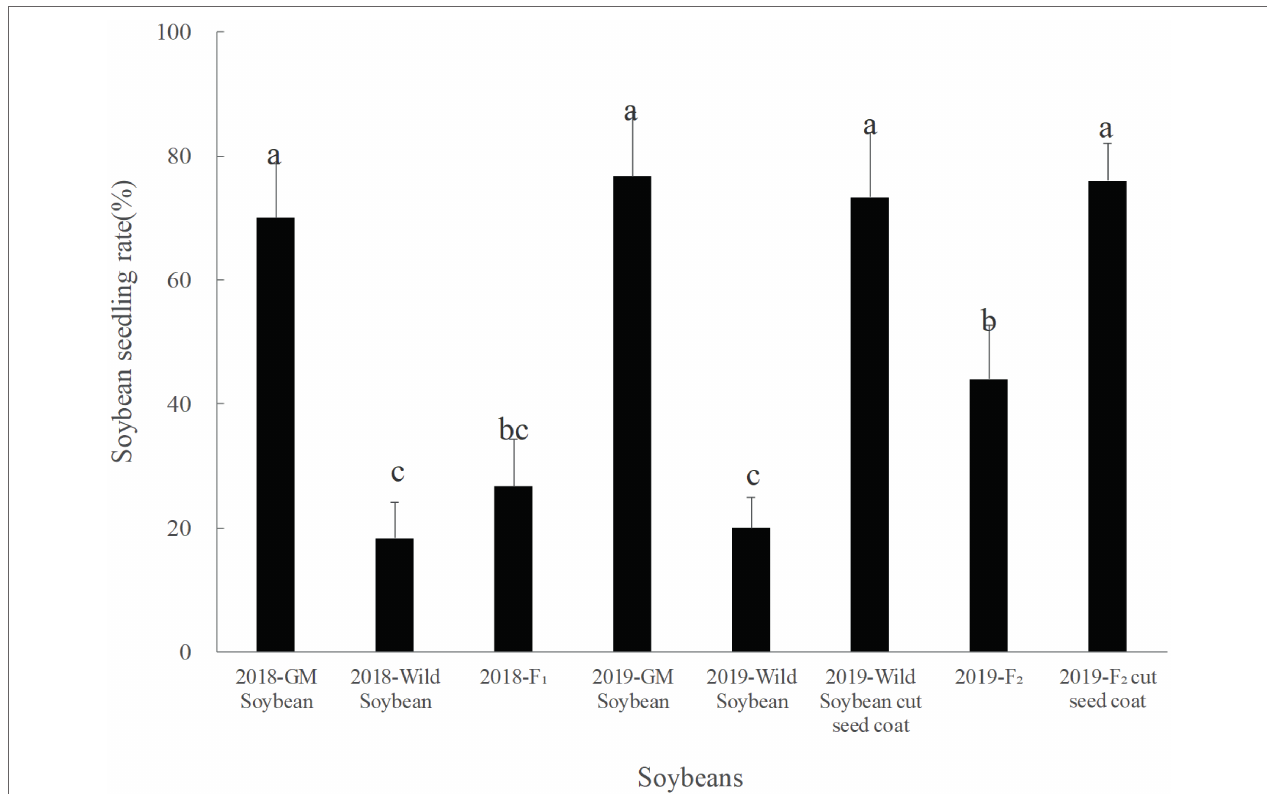
FIGURE 1 | Emergence rate (%) of transgenic, wild soybeans, and hybrid progeny. The letters indicate that there is no significant difference in seedling emergence rate among soybean materials ( p >